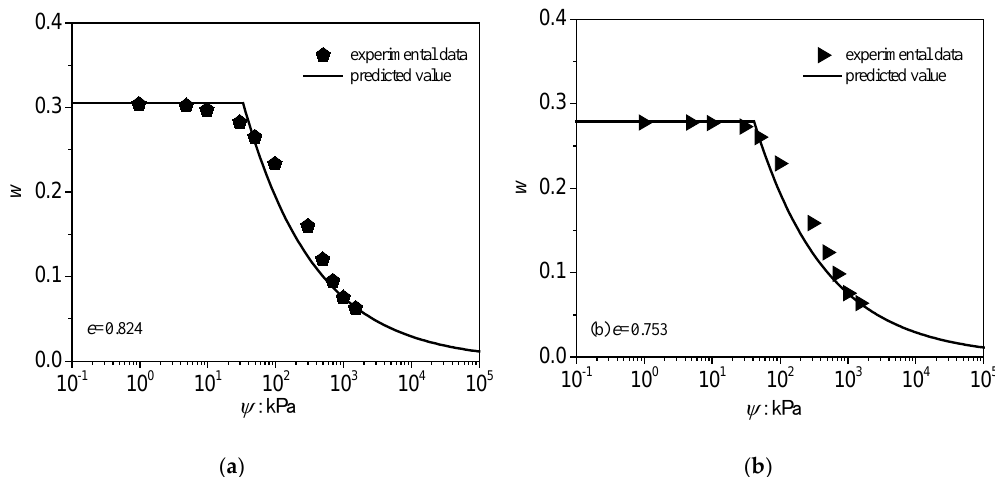
Figure 11. Measured and predicted SWCCs for Guangxi expansive soils at deformed state at ( a ) e = 0.824; ( b ) e = 0.753 (data after Miao et al. [42]).